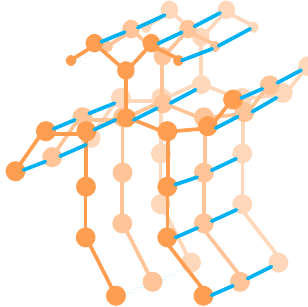
Figure 2. The spatial–temporal graph. Orange dots denote body joints. The blue line represents the inner edge between the naturally connected body joints.